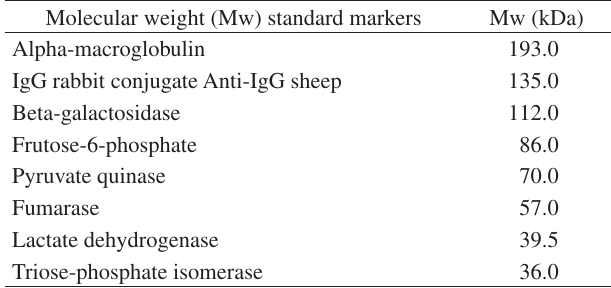
Table 2. Standard Molecular weight markers for collagen characterization.